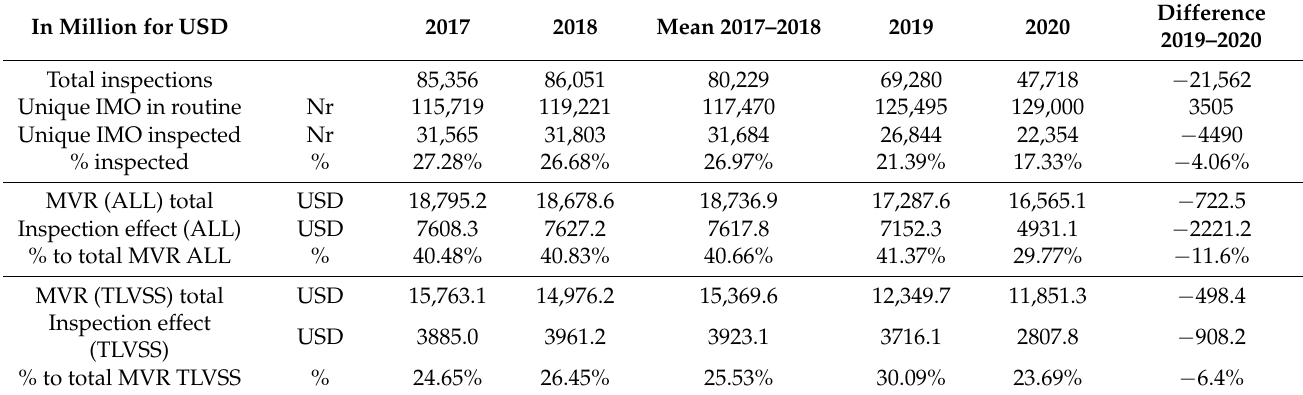
Table 6. Averted incident costs due to inspections (million